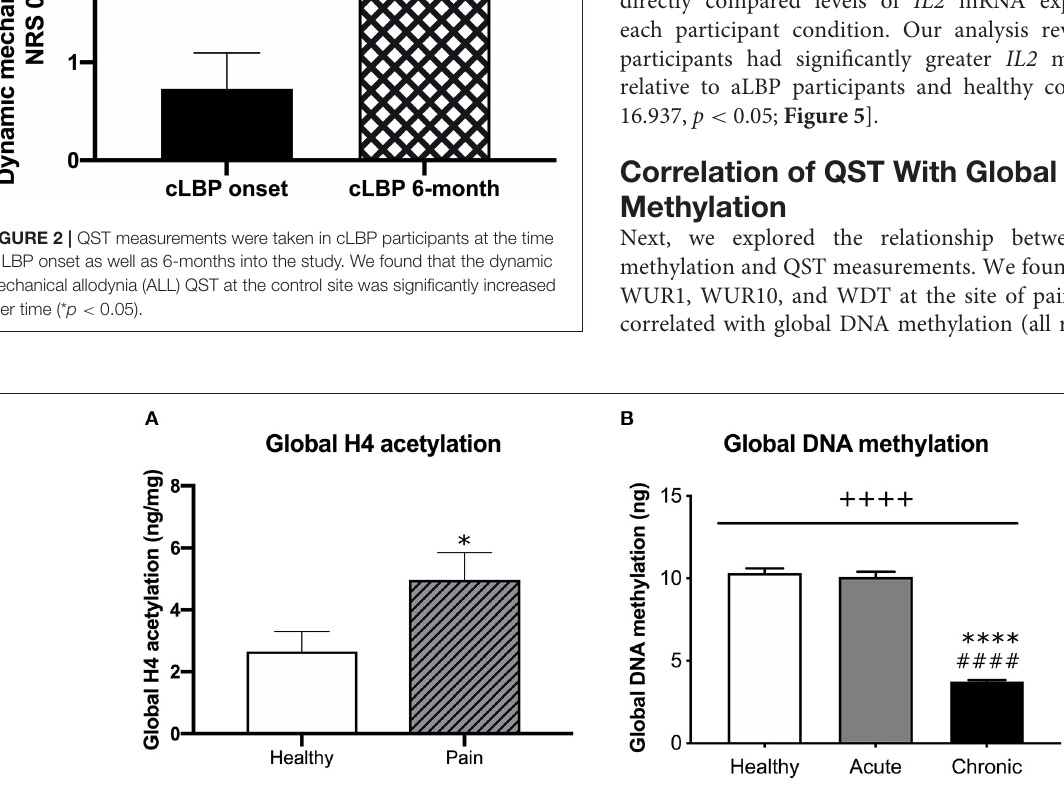
Frontiers in Pain Research |